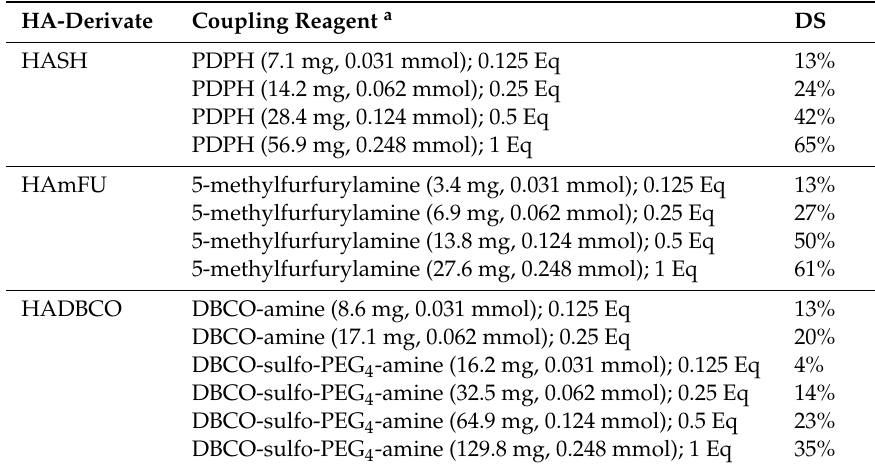
Table 1. E ff ect of coupling-reagent equivalents on the synthesis of HA-derivates via DMTMM-activation and corresponding DS.